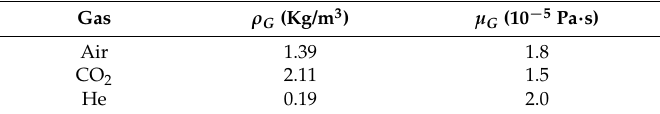
Table 4. Gas phase